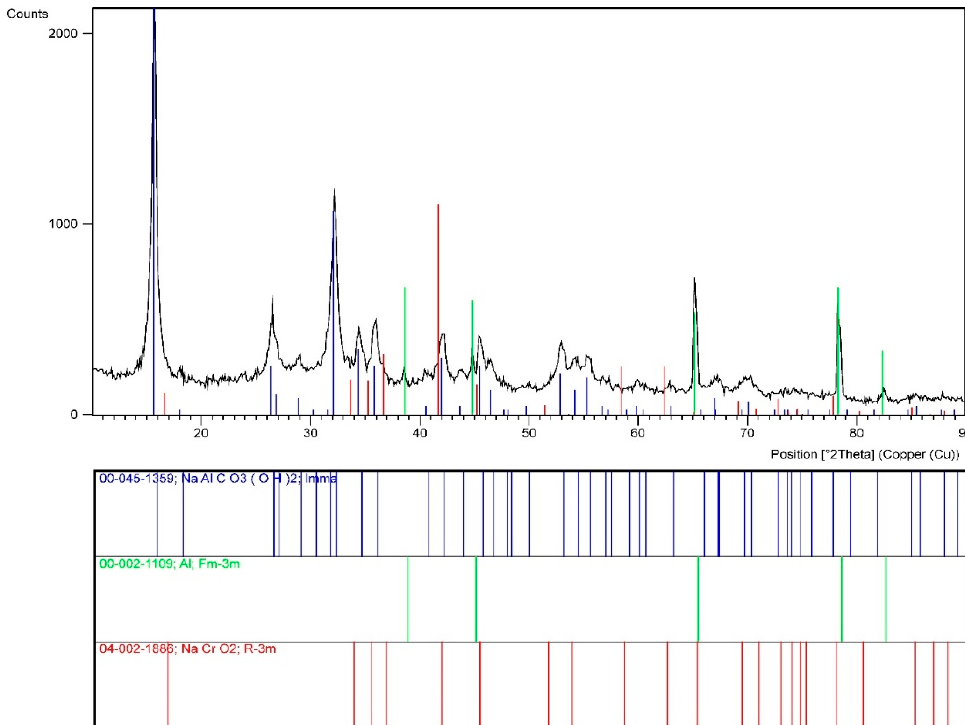
Figure 5. GIXD pattern for the angle of incidence α = 0.50°obtained for the 02G sample subjected to thermo-chemical treatment in distilled water.